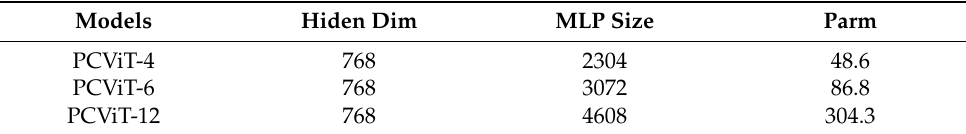
Table 4. Number of three network parameters.